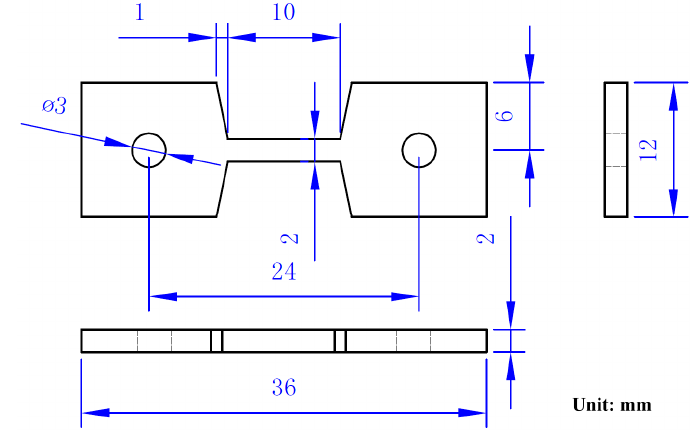
Figure 1. Schematic diagram showing the dimensions of the specimen for the short-term creep